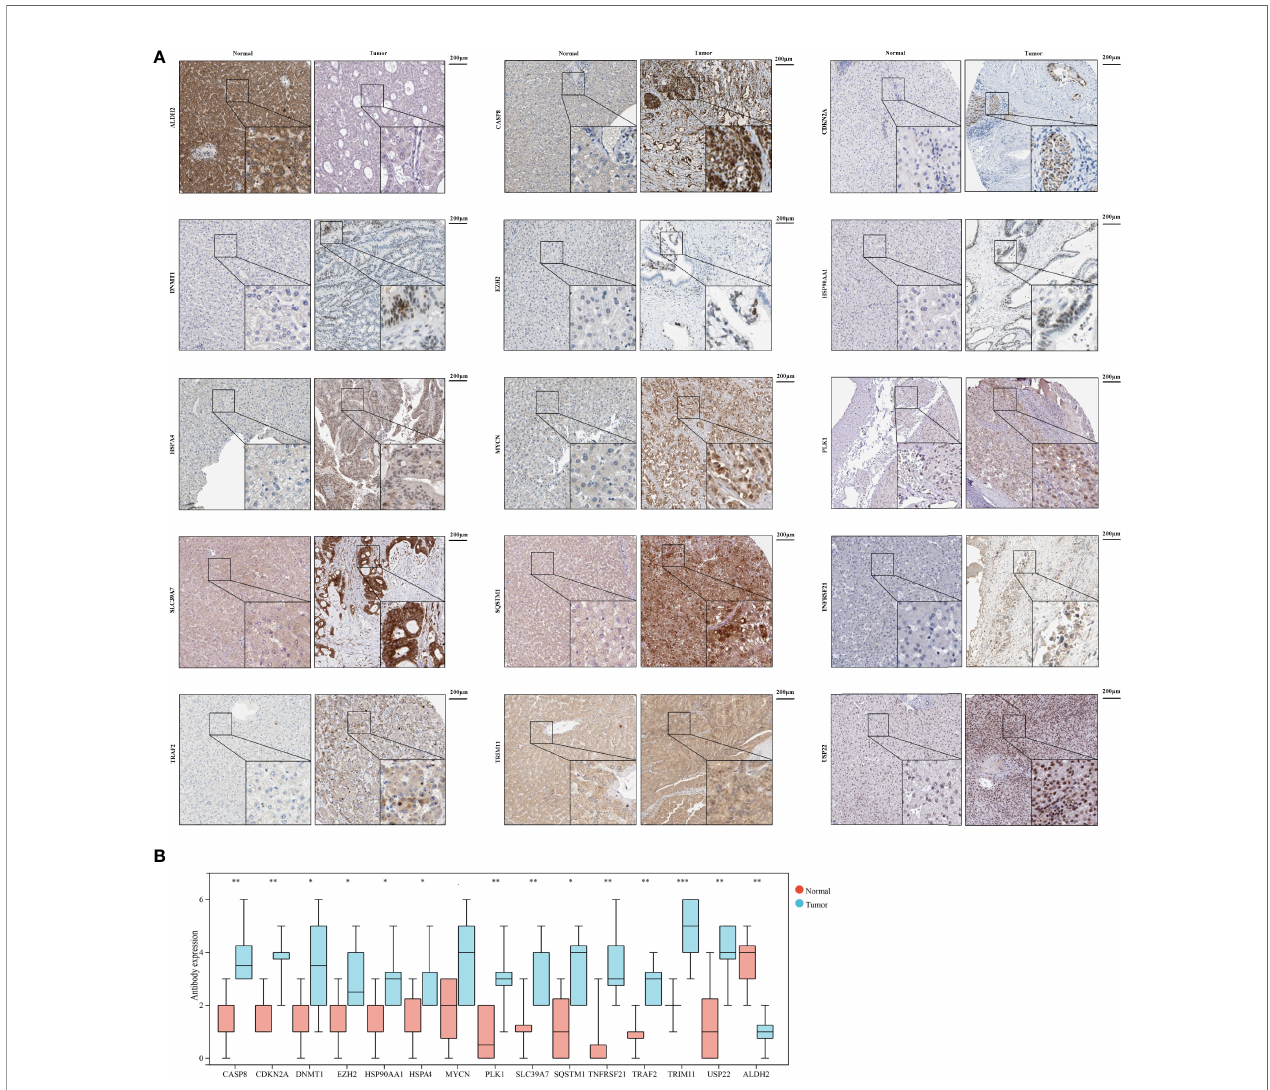
FIGURE 10 | The expression of 15 necroptosis genes in HCC by IHC. (A) IHC staining of 15 necroptosis genes in HCC and normal tissues. (B) Statistic data of IHC analysis (N = 8). (*P < 0.05; **P < 0.01; ***P <